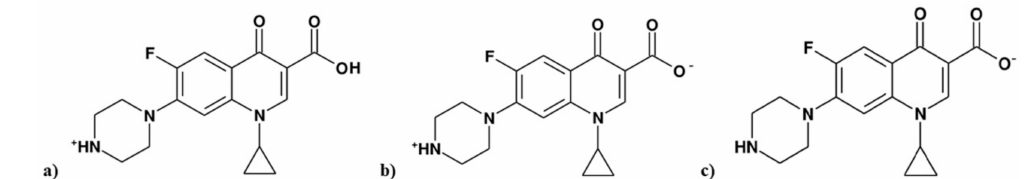
Figure 1. The molecular structures of CIP depending on pH: ( a ) cationic form (in the range 3–6); ( b ) zwitterionic form (in the range 6–9); and ( c ) anionic form (in the range 9–12).